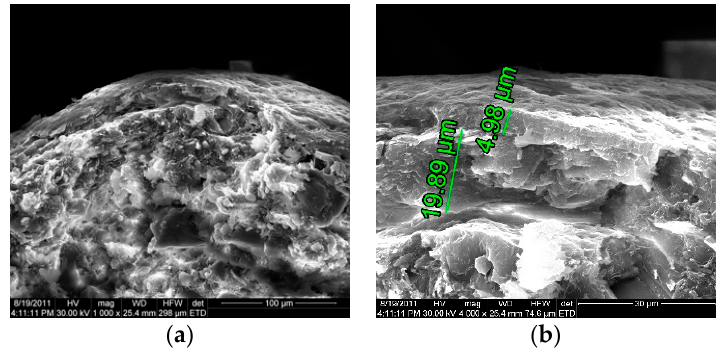
Figure 7. ( a ) SEM image (1000×) of the cross-section of MXA samples; ( b ) example of SEM image (4000×, BSED) of the cross-section of MXA samples.